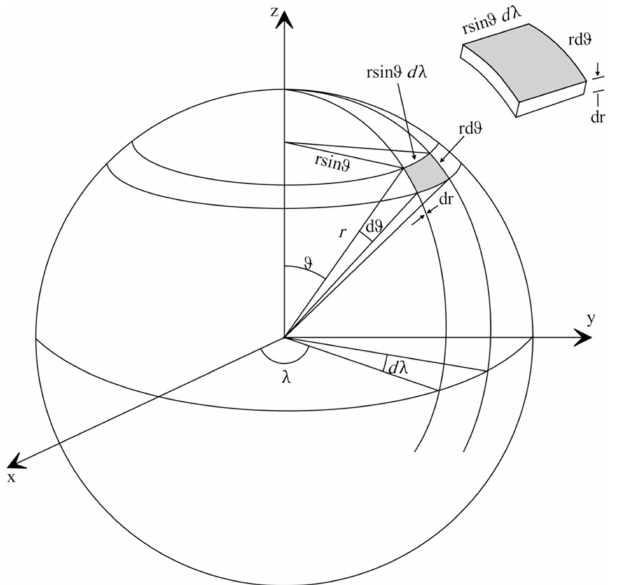
Figure 3. Sub-division in a longitude–latitude grid and a differen- tial volume element of the sphere (Abedini et al., 2021a). In an al- ternative interpretation, the figure illustrates a two-dimensional step function on the sphere, which is either zero (white) outside and con- stant but non-zero (grey) inside a mascon